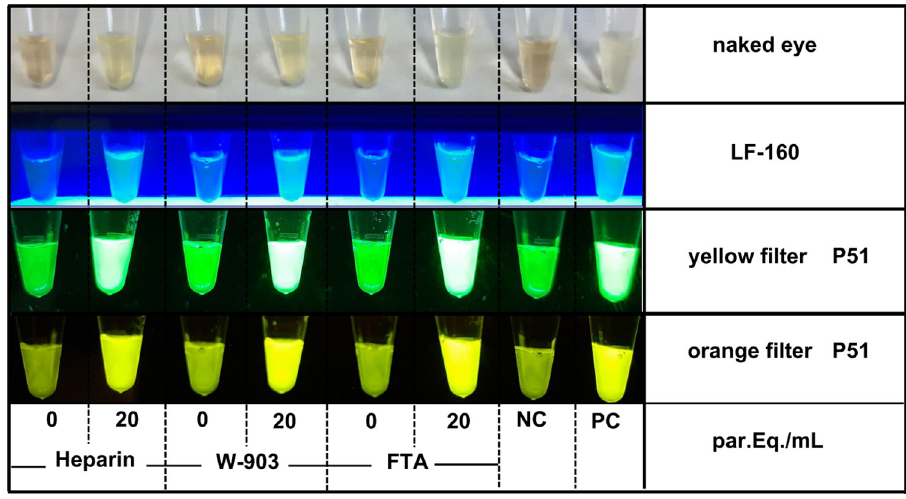
Fig 2. Visualization of LAMP results. From top to bottom: visualization by naked eye; by using the LF-160 device; and the P51 fluorescence viewer with a yellow acrylic sheet (above) and an orange acrylic sheet (below). Positive blood samples contain 20 par. Eq./ mL of Sylvio X-10 stock on the indicated support. NC and PC are negative and positive controls, respectively, provided in the kit.